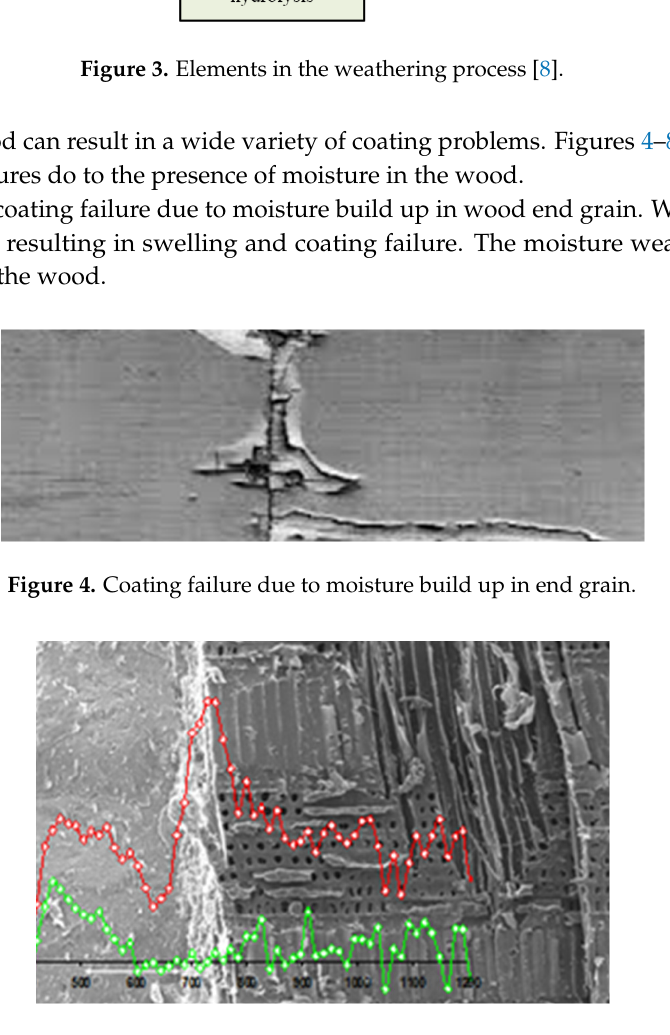
Figure 3. Elements in the weathering process [8].